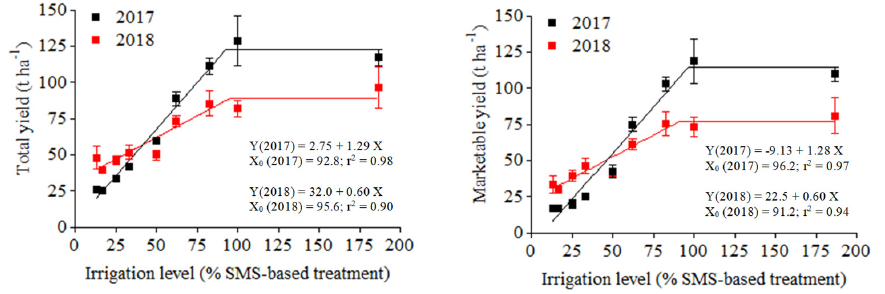
Figure 3. Effect of irrigation levels on total and marketable yield of processing tomato in 2017 and 2018. Data are means of three replicates ± standard errors. SMS = soil moisture sensor. Linear-plateau regression models for each year and crop traits are displayed in the figure.